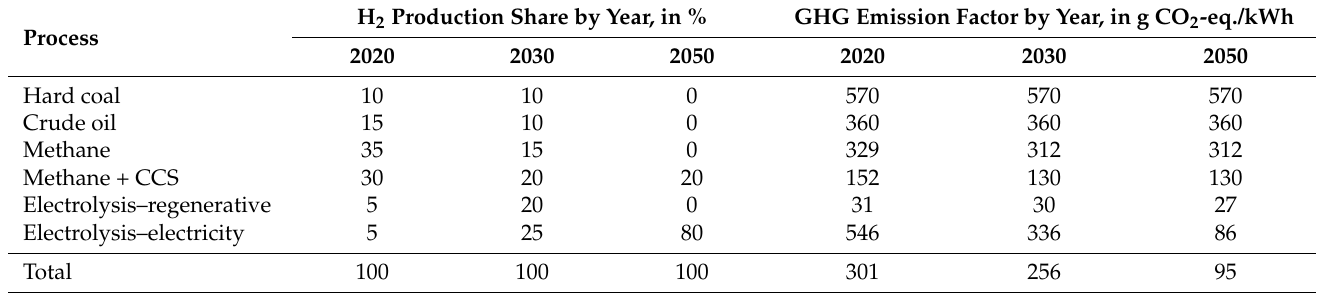
Table 11. H 2 production shares [20,31,67] and GHG emission factors [67–69] by process and year.